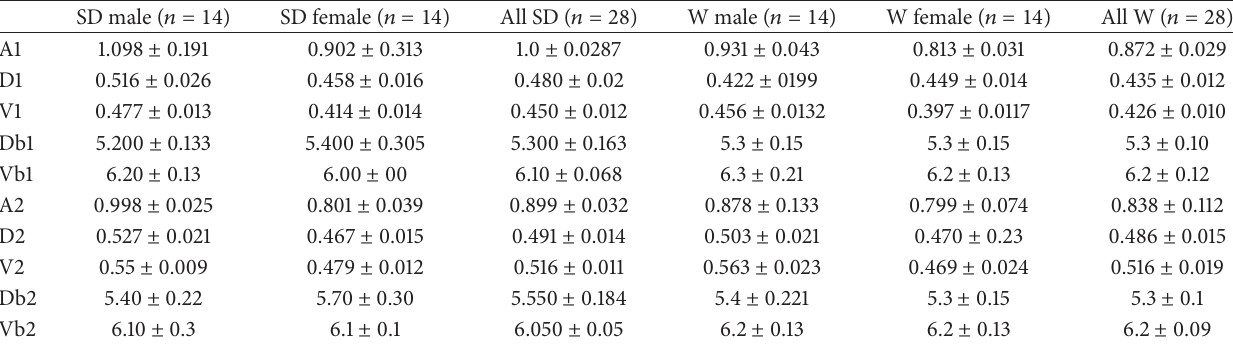
A1: the length of root of right renal artery; A2: the length of root of left renal artery; D1: the length of the dorsal branch of right renal artery; D2: the length of the dorsal branch of left renal artery; V1: the length of the ventral branch of right renal artery; V2: the length of the ventral branch of left renal artery; Db1, Vb1, Db2, DV2: the number of interlobar arteries of the dorsal and ventral branch of right renal artery and left ones, respectively.